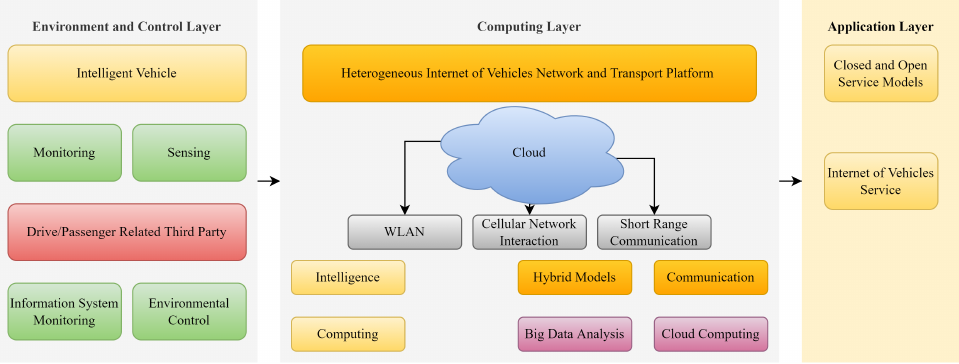
Figure 1. Key components and layers of an IoV